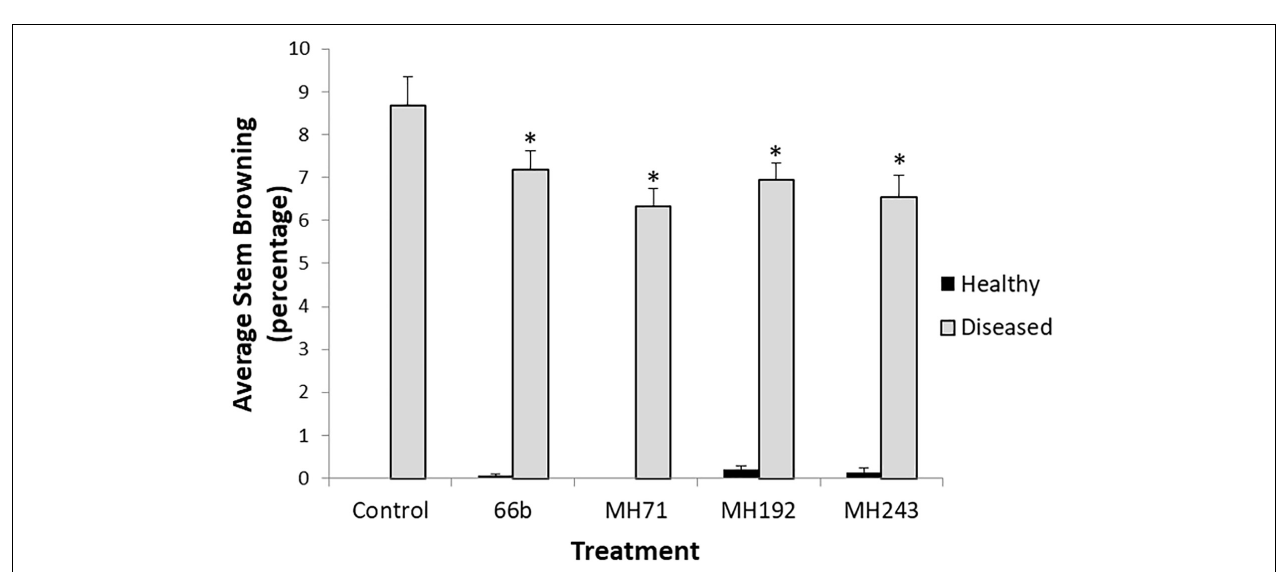
FIGURE 7 | Crown rot symptoms (% stem browning) observed on seedlings grown from seeds coated with Actinobacteria (MH71 and MH243) and inoculated with F. pseudograminearum CS5642 in 3 separate seedling-scale experiments. Inoculation with MH71 or MH 243 decreased disease expression by between 75 and 100%. Different letters (a,b) denote significant difference at P < 0.05 from ANOVA analysis.